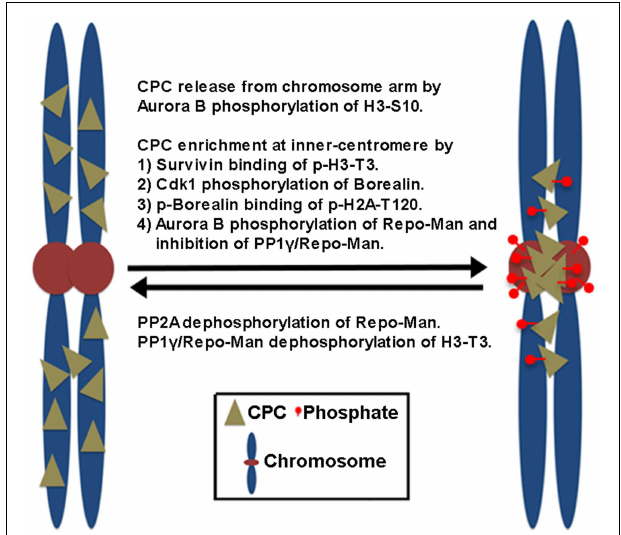
FIGURE 1 | The proposed mechanisms of CPC enrichment at the inner centromeres. Aurora B-dependent phosphorylation of histone H3 on Ser10 (H3-S10) dissociates the CPC from the chromosome arm. Subsequently, the CPC enriches at the inner centromeres. This involves the direct and indirect interaction of Survivin and Borealin with the centromere-specific phosphorylated histone markers (p-H3-T3, p-H2A-T120) at the inner centromeres created by Haspin and Bub1 kinases. Cdk1 phosphorylation of Borealin is required for Borealin binding to the histone marker H2A-T120 phosphorylated by Bub1 kinase. In contrast, PP1 γ /Repo-Man phosphatase acts antagonistically by dephosphorylating the histone makers at the chromosome arm. At the centromeres, Aurora B phosphorylation of Repo-Man on Ser893 prevents PP1 γ /Repo-Man recruitment to histones, thereby the CPC is enriched at the inner centromeres. Conversely, PP2A reverses this inhibitory phosphorylation of Repo-Man by Aurora